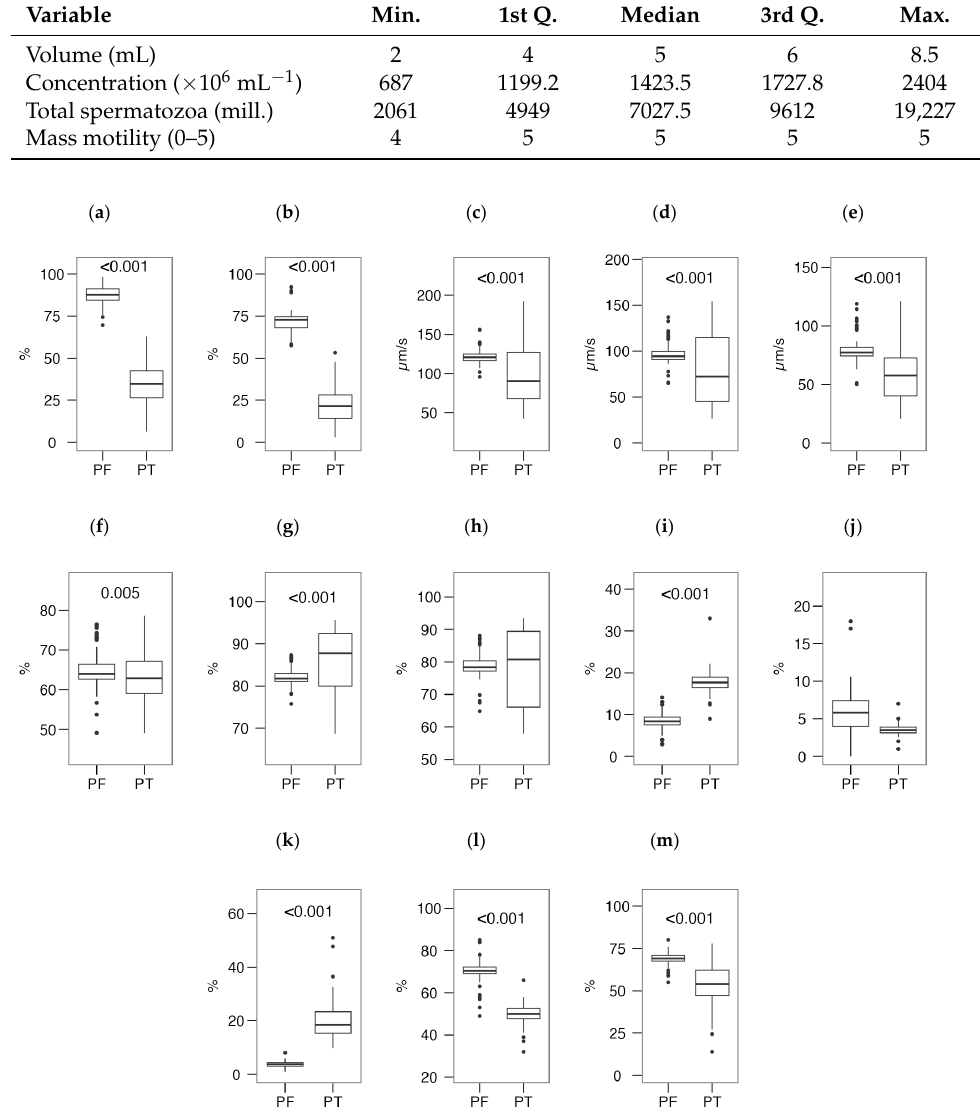
Figure 1. Descriptive statistics from the pre-freezing (PF) and post-thawing (PT) semen analysis (40 Asturiana de la Montaña bulls, 102 ejaculates). Box-plots show 1st and 3rd quartiles of the distribution (box limits), median (inner line), upper and lower hinges of the distribution (vertical lines, extreme observations within 1.5 times the interquartile limits), and outliers (dots, observations outside the upper/lower hinges). p values for the e ff ect of the freezing/thawing process are shown on the top when p ≤ 0.05. ( a ) Total motility. ( b ) Progressive motility. ( c ) VCL. ( d ) VAP. ( e ) VSL. ( f ) LIN. ( g ) STR. ( h ) WOB. (i) Abnormal forms. ( j ) Cytoplasmic droplets. ( k ) Damaged acrosomes. ( l ) HOST. ( m ) Viability.